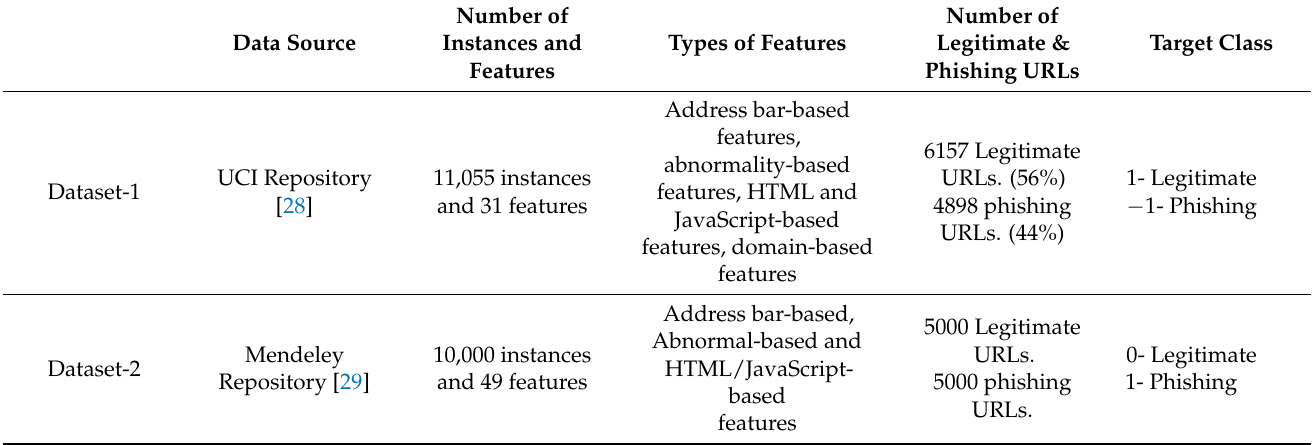
Table 4. Summary of the datasets.